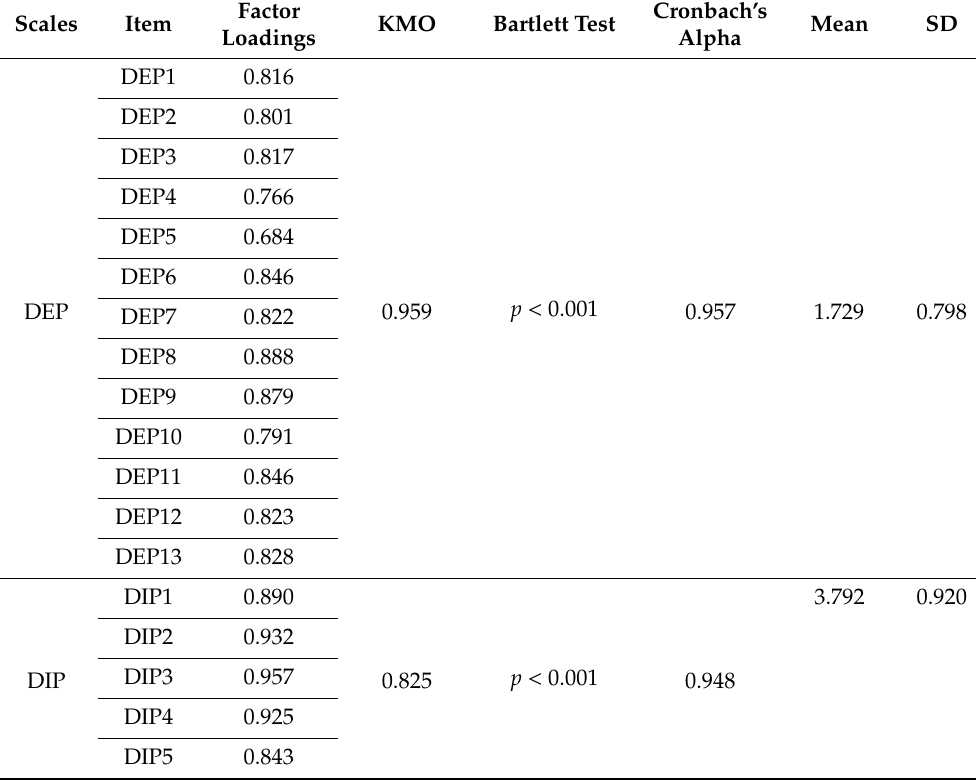
Table 3. Reliability and validity of measure